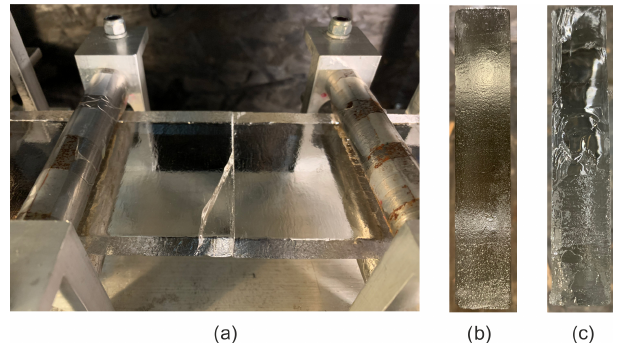
Figure 5. Photographs of ice sample #38 right after forced fail- ure (a) ; the saline bond surface of 10ppt after a crack propagated fully through the bond, sample #19 (b) , and partially through the parent material, sample #47 (c)